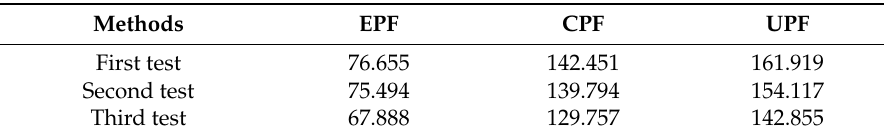
Figure 6. Battery model outputs under City test: ( a ) model output; and ( b ) model error. Table 2. Estimated accuracy. Methods